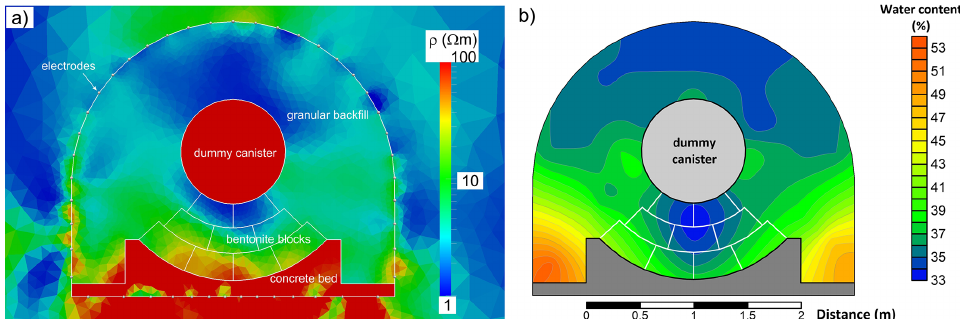
Figure 6. (a) Model of the spatial resistivity distribution on 30 September 2012 (Furche and Schuster, 2014); (b) spatial distribution of water content as a result of sample analysis while dismantling (after Palacios et al., 2013).